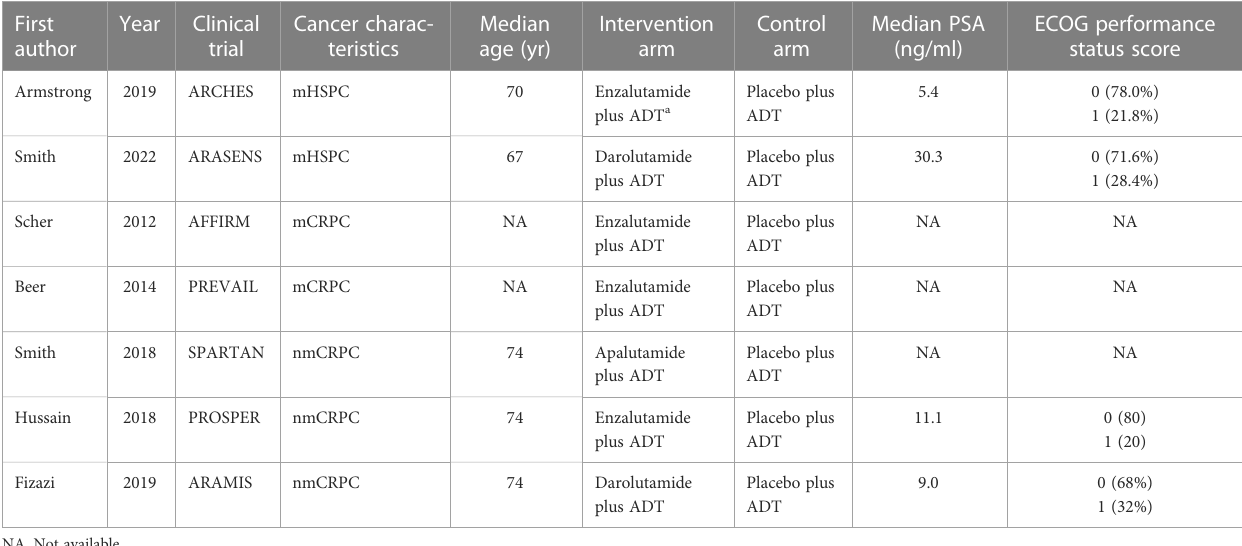
NA, Not available. a Androgen deprivation therapy (ADT): Surgical (bilateral orchiectomy) or chemical (pharmaceutical) interventions resulting in the reduction of serum testosterone or blockade of the androgen receptor.